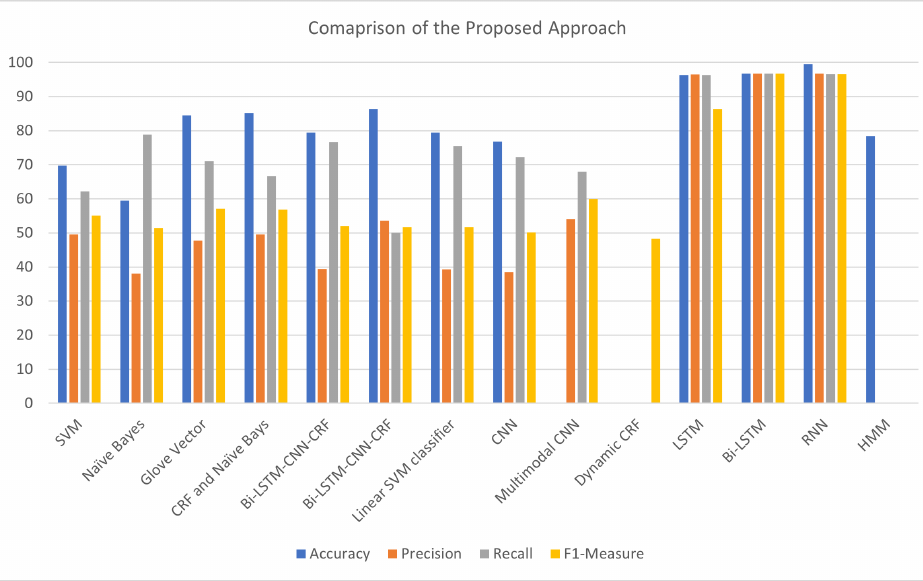
Figure 11. Comparison of the proposed approach with existing state-of-the-art approaches. Table 6. Comparison with the present state-of-the-art